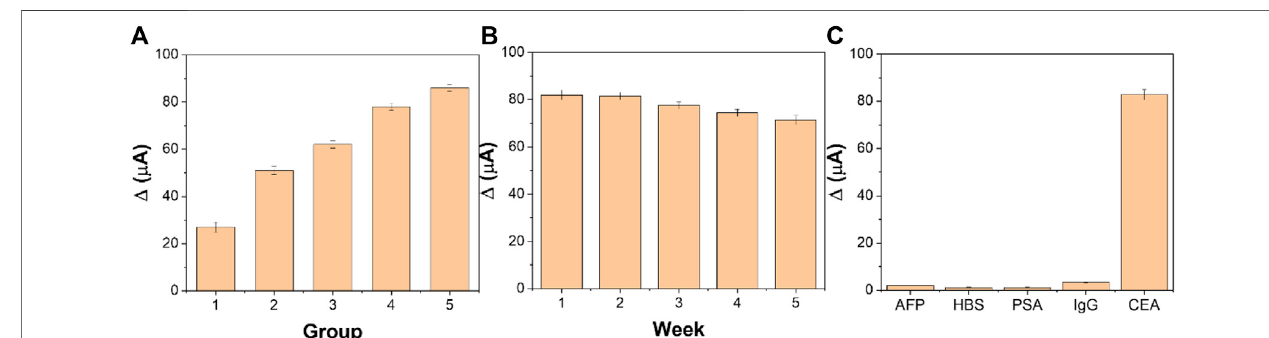
FIGURE 9 | (A) Reproducibility, (B) stability, and (C) speci fi city of the fabricated immunosensor ( n = 3).